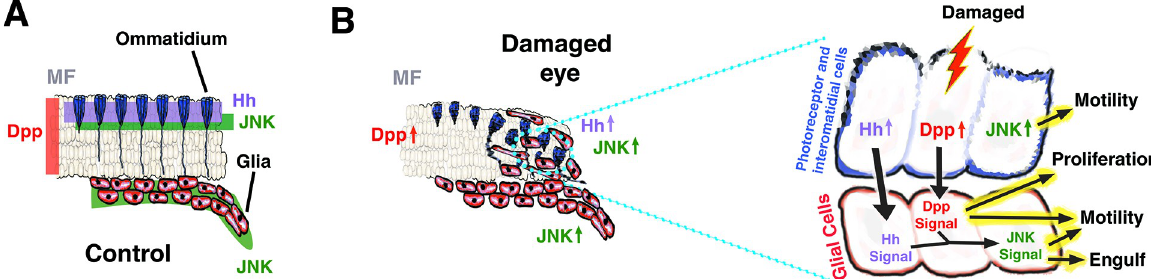
Fig 12. Model representing the signalling network involved in the activation of glial response after cell death induction in eye discs. (A) In the eye discs, Hh is expressed in the interommatidial and photoreceptors cells, behind the MF (purple). The expression of Dpp is located ahead of the MF (red). JNK is expressed in the glial cells and the retina (green). (B) Damage promotes a GRR consisting of increased glial migration and division. Moreover, it is stimulated the engulfment activity of glial cells for removing cellular debris and apoptotic corpses. When cell death is induced in the retinal tissue, the Hh and Dpp pathways induce glial cell proliferation and migration and activate the JNK pathway that facilitates glial migration and engulfment. The basal displacement of photoreceptors is likely due to the restructuring of the epithelium caused by apoptotic induction. Dpp, Decapentaplegic; GRR, glial regenerative response; Hh, Hedgehog; JNK, c-Jun N-terminal kinase; MF, morphogenetic